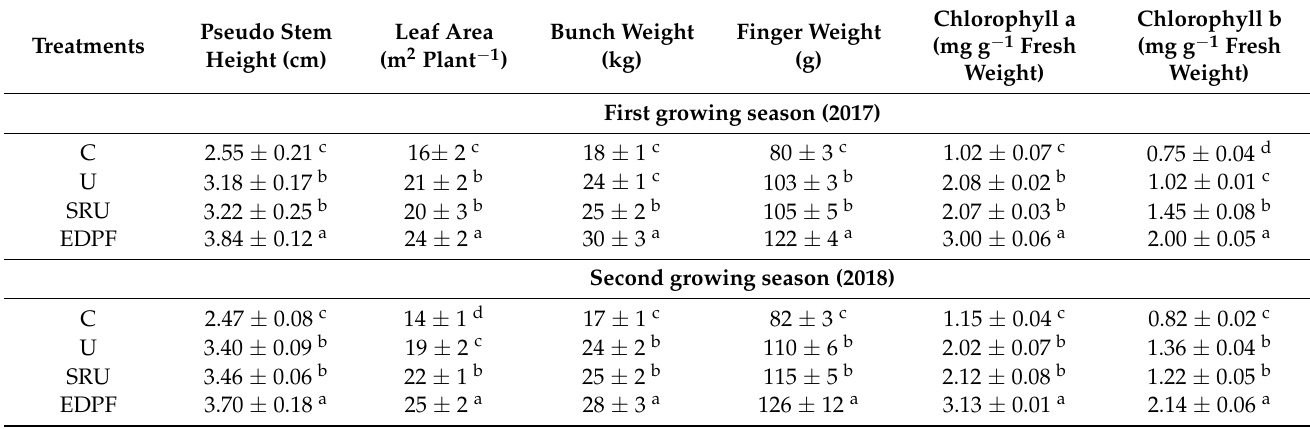
Table 3. Effect of nitrogen forms on the growth of Williams banana.